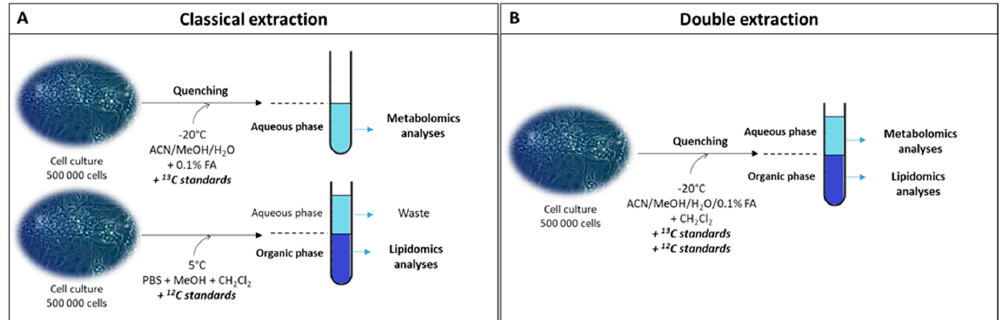
Figure 1. Experimental scheme of the classical and double extraction methods used to perform metabolomics and lipidomics analyses. For the classical extraction ( A ), a mix of acetonitrile (ACN), methanol (MeOH), and acidified water (H 2 O) with formic acid (FA) was used to perform polar metabolites’ extraction. Phosphate buffer saline (PBS) associated with dichloromethane (CH 2 Cl 2 ) and methanol was used to extract lipids. For the double extraction method ( B ), the mix of acetonitrile, and lipids on the same sample. 13 C and lipids internal standards were added to perform absolute quantification and relative quantification for metabolomics and lipidomics analysis, respectively.